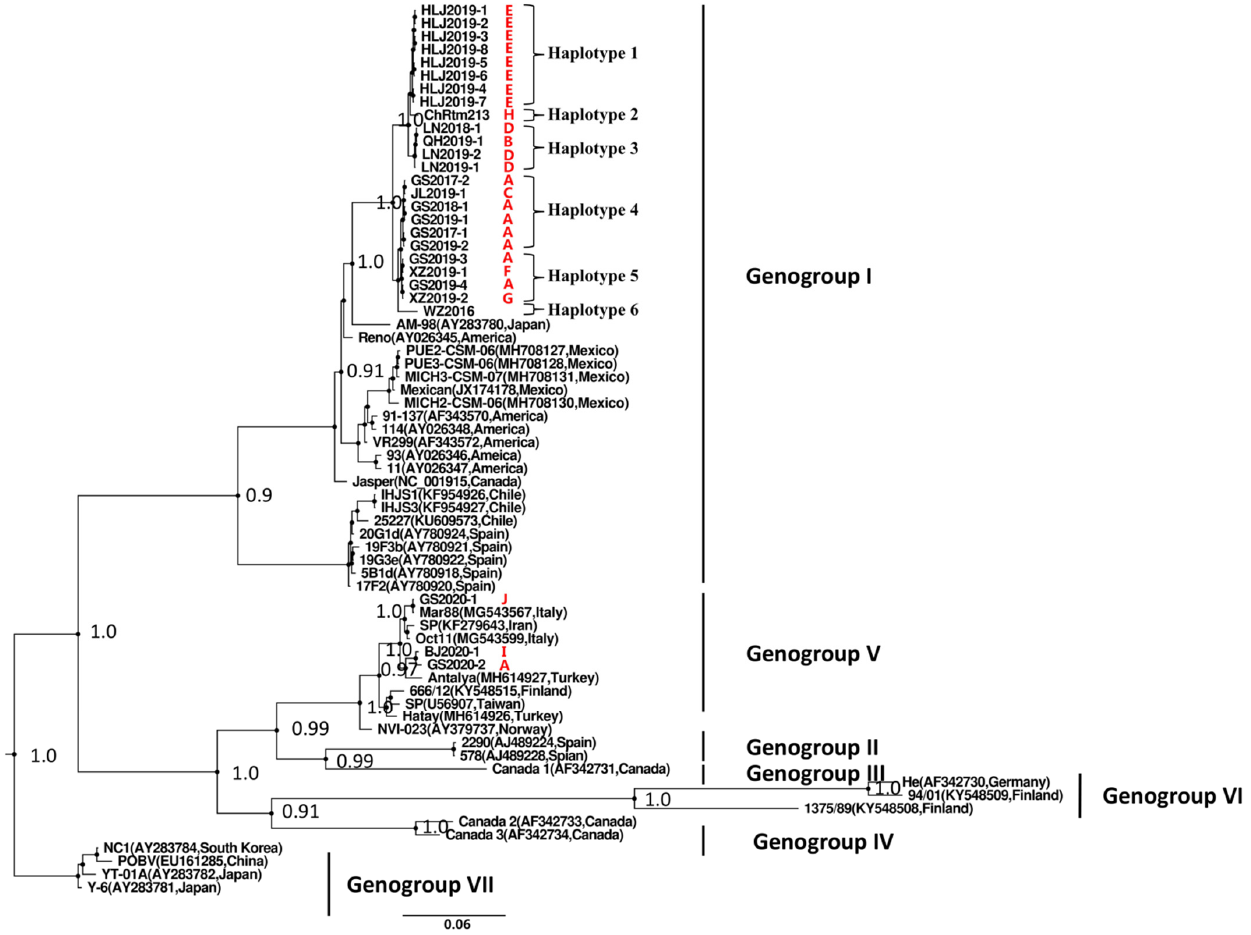
Figure 3. Phylogenetic tree of IPNV isolates constructed based on the VP2 gene CDS by using Bayesian Inference method. The main nodes with pp value of higher than 0.9 are labeled. All of the Chinese IPNV isolates (red labels) clustered within genogroup I and V, respectively. Red capital letters indicated fish farms. Information of IPNV isolates used here was listed in Tables 1 and 3.